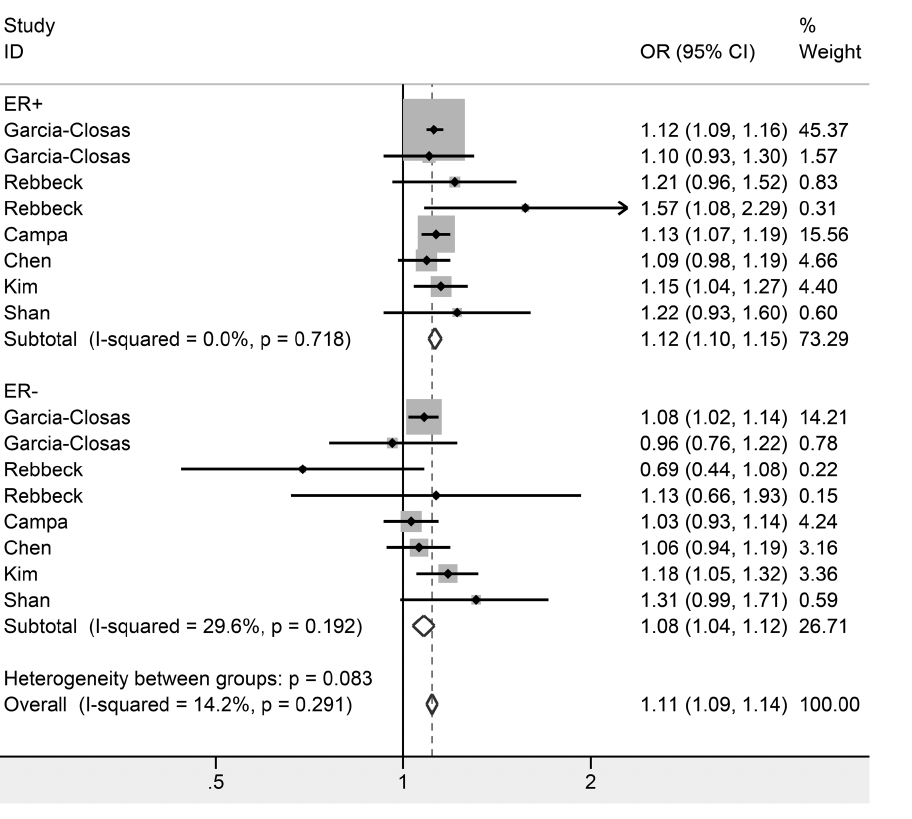
Figure 4. Forest plot of MAP3K1 rs889312 polymorphism and breast cancer risk stratified by ER status. Fixed-effect model was used for the analysis (allele contrast model C vs. A).